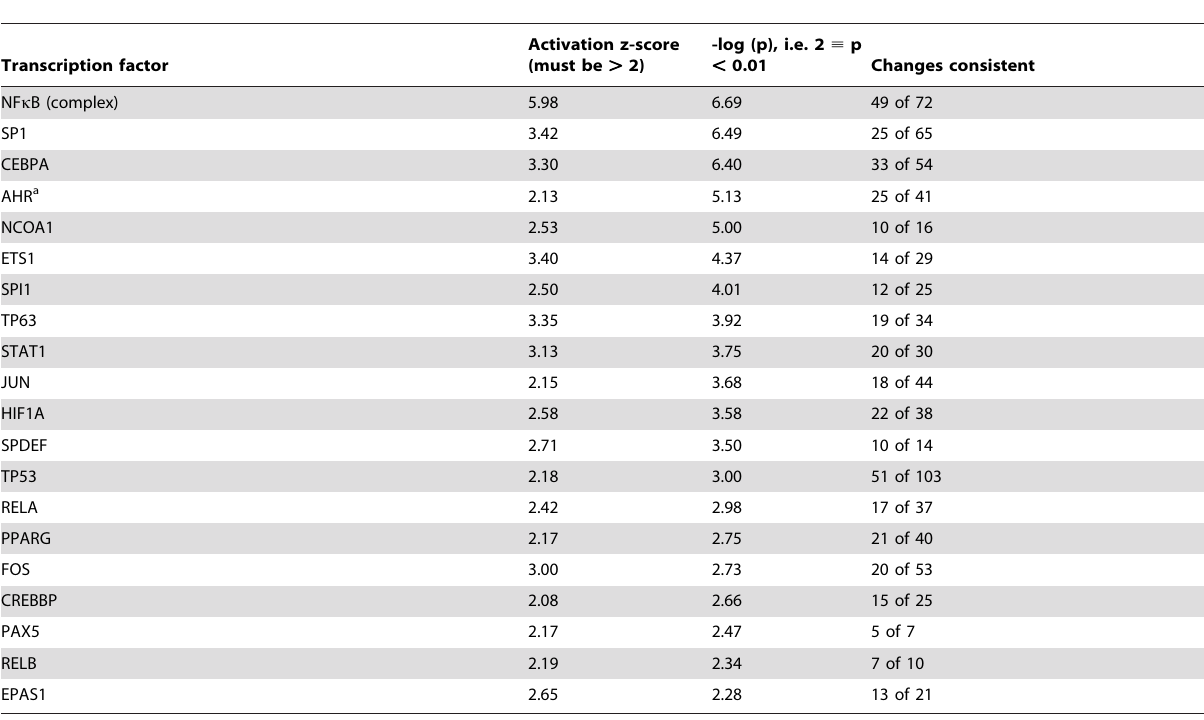
Table 4. Transcription factors identified by Ingenuity Pathway Analysis as modulated by endometrial C. trachomatis infection (determined by z-score).